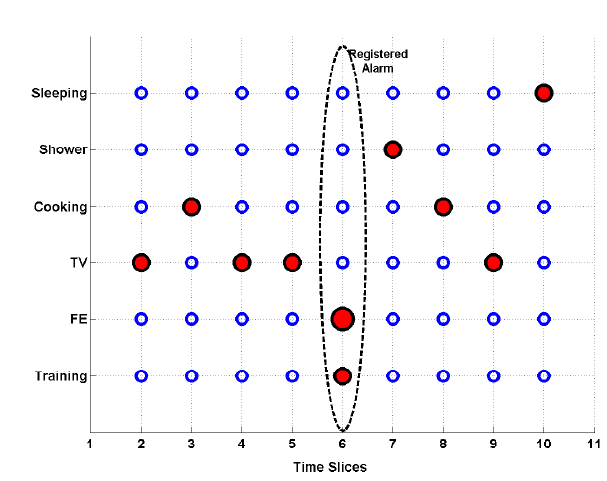
Figure 6. Simulation